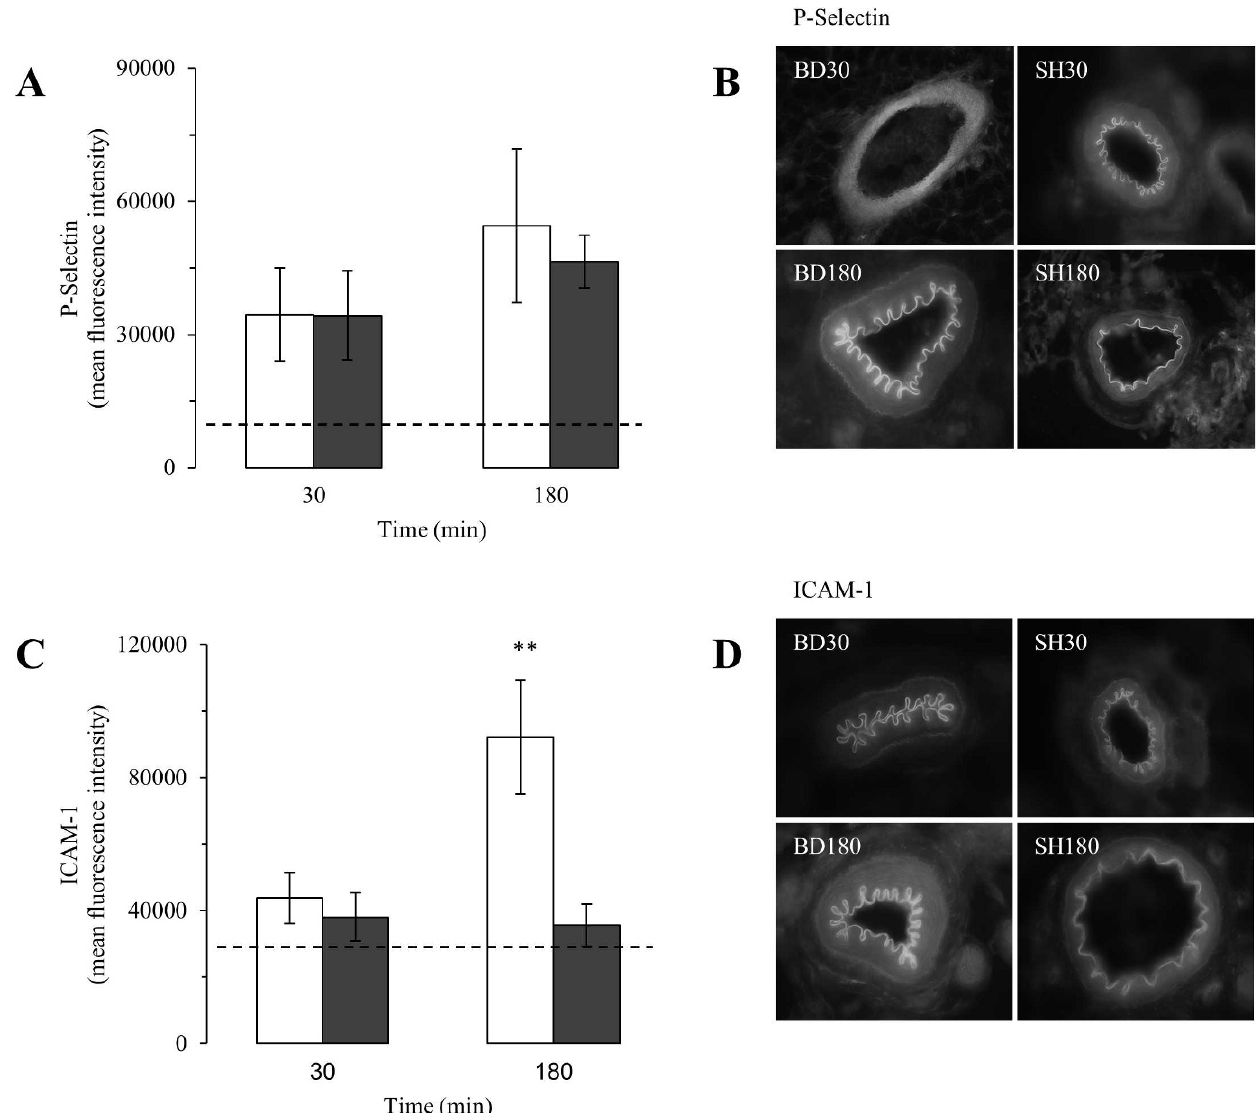
Figure 3 - Expression levels of P-selectin (A and B) and ICAM-1 (C and D) in the mesenteric microvessels in brain-dead (BD, white columns) and sham-operated (SH, gray columns) rats 30 and 180 min after the surgical procedure. The values are presented as the mean ¡ SEM for nine samples/rat, three rats/group. The dashed lines indicate the basal values. ANOVA P-selectin p =0.43; ICAM-1 p =0.003. ** p , 0.01 vs. SH at the same time point.